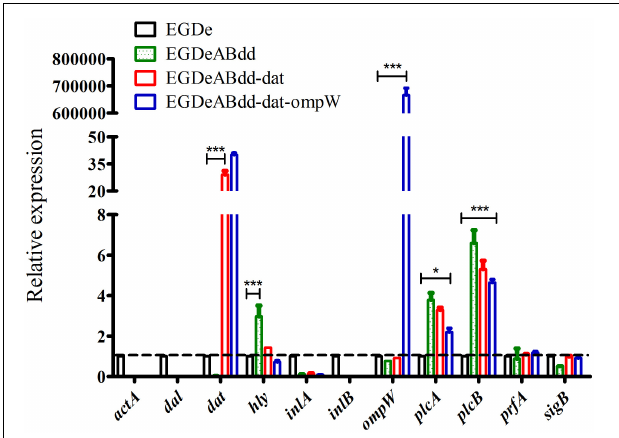
FIGURE 6 | RT-PCR detection of virulence gene relative expression levels. Gene transcription of EGDe was considered to be 1, and others were compared with it. Value > 1 indicated gene high expression; otherwise, it represented low expression. * P < 0.05; *** P <